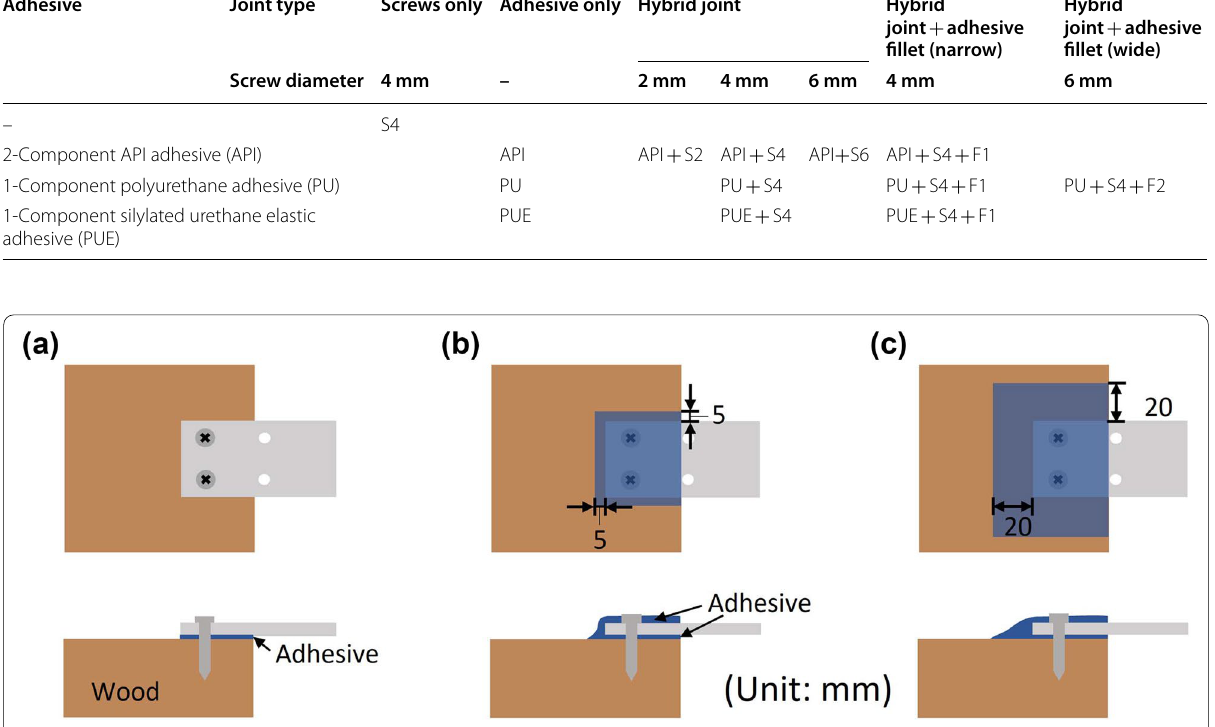
adhesive fillet +